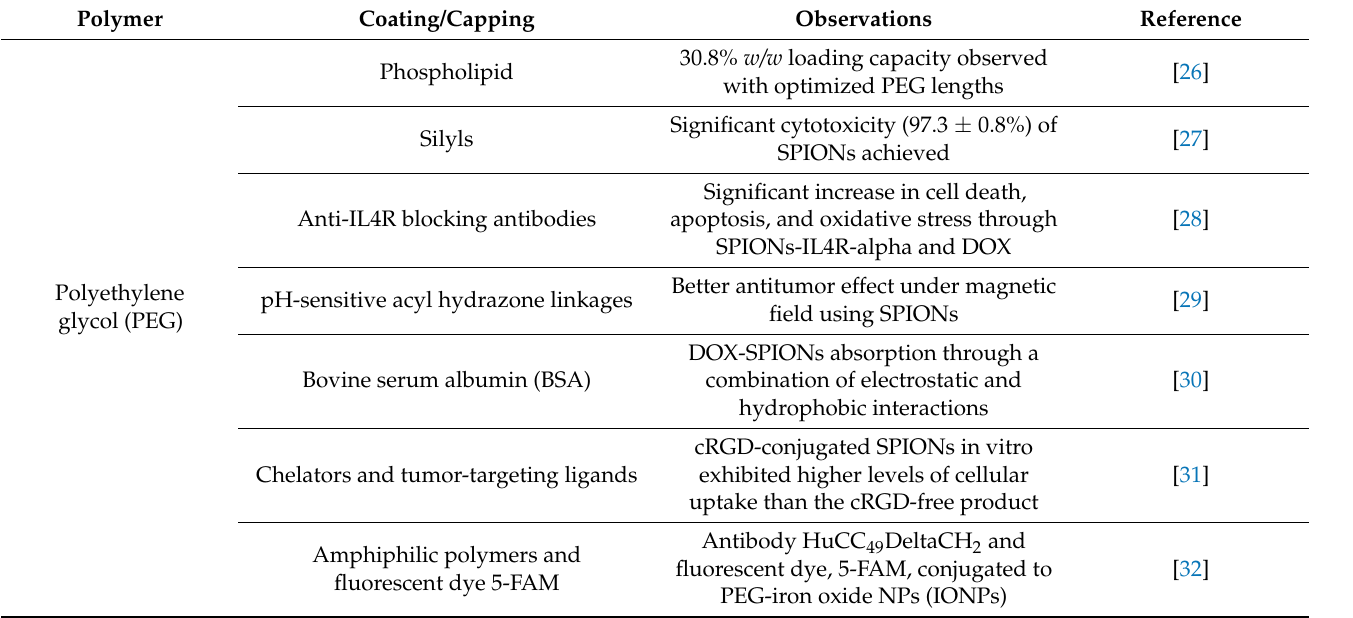
Table 1. SPIONs–polymer conjugated system for DOX